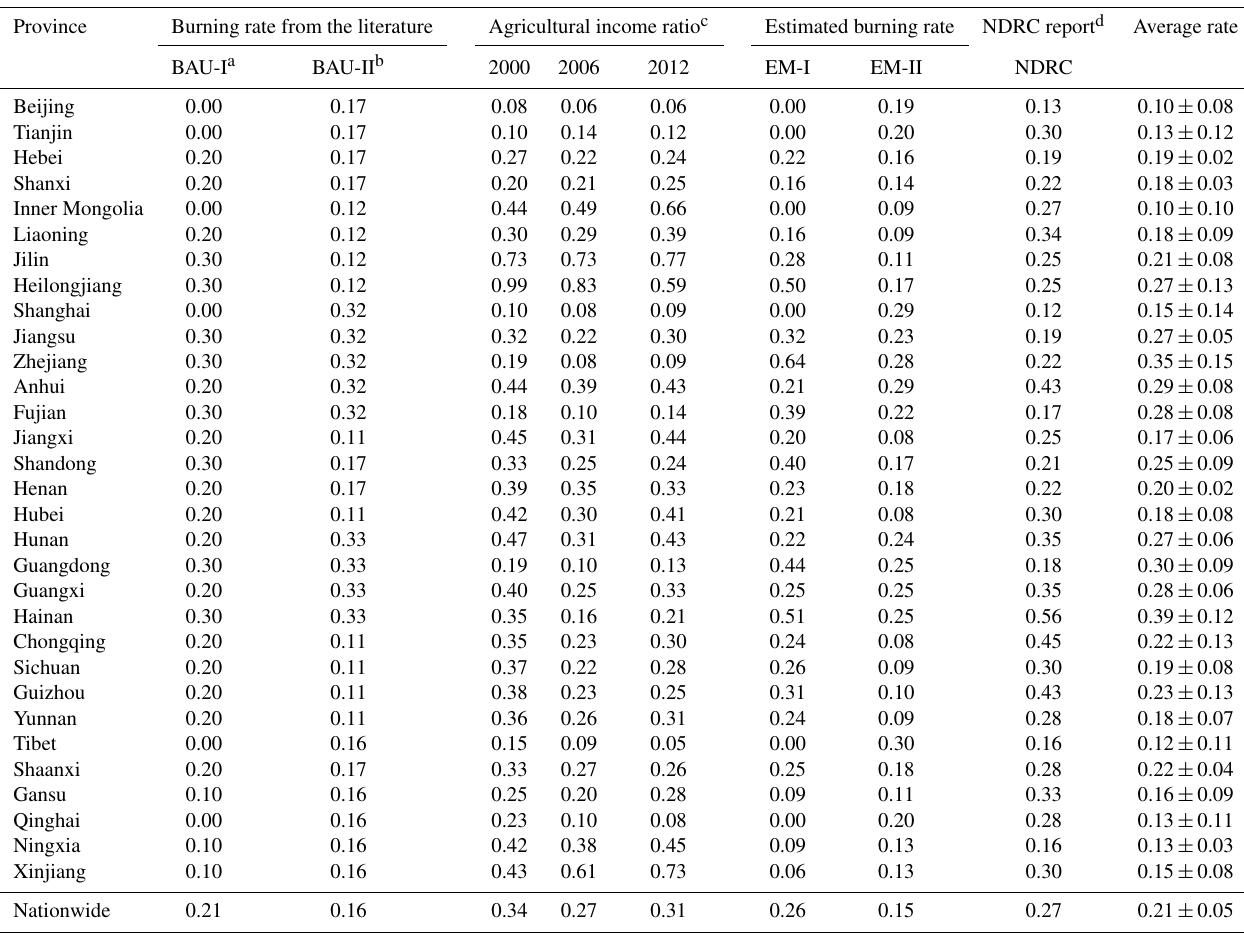
Table 4. Summary of field burning rates and economic data in China. Province Burning rate from the literature Agricultural income ratio c Estimated burning rate NDRC report d Average rate BAU-I a BAU-II b 2000 2006